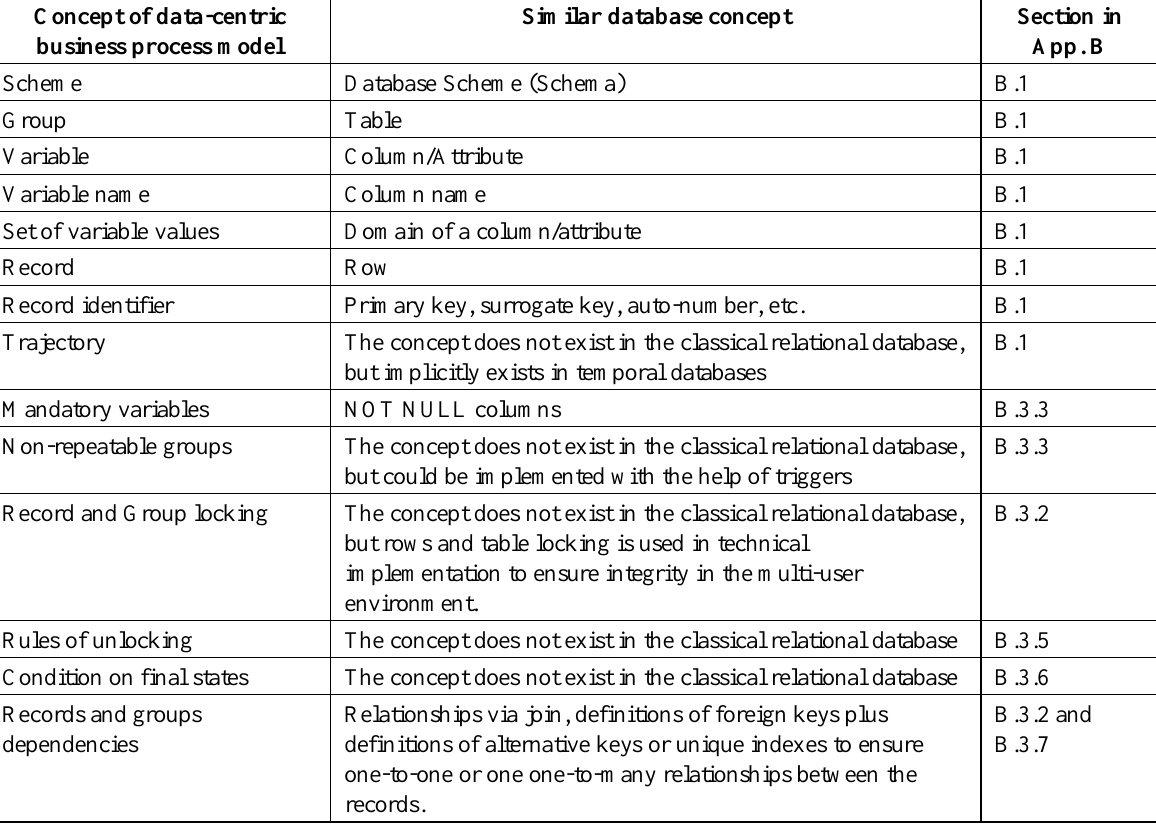
Table 1. Main concepts of the formal data-centric business process